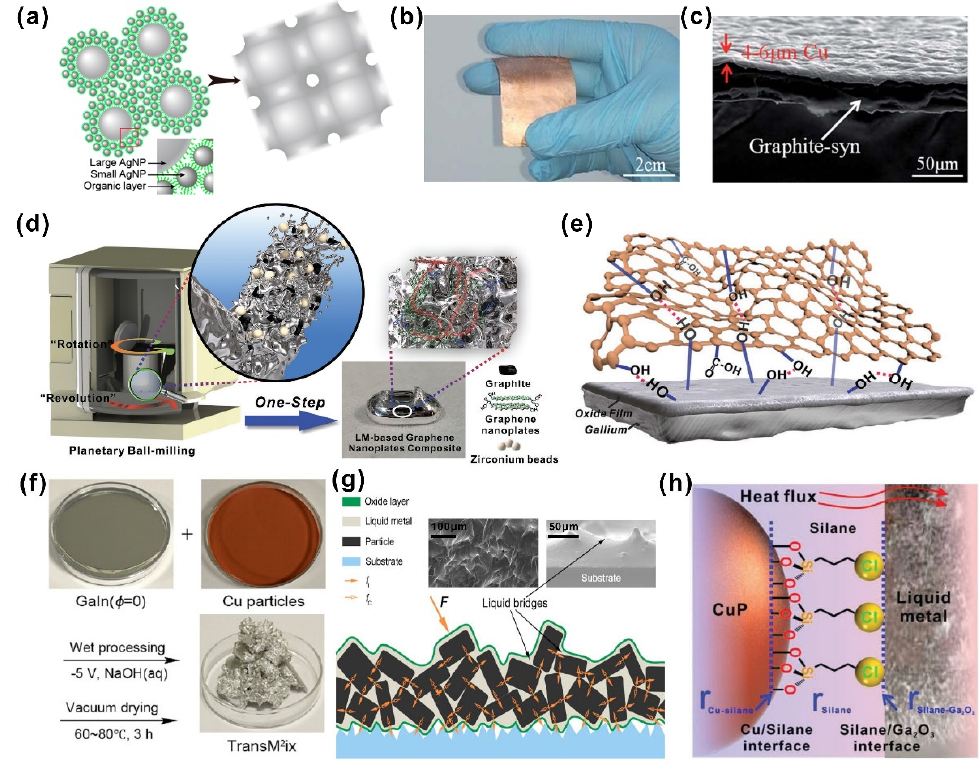
Figure 3. ( a ) The bimodal silver nanoparticle pastes via a sintering approach (Reprinted/adapted with permission from Ref. [65]. 2015, the American Chemical Society). ( b ) The picture of copper–graphite–copper (Cu–G–Cu) sandwich ‐ structured TIMs. ( c ) The cross ‐ sectional SEM image of the Cu–G–Cu sandwich (Figure 3b,c reprinted/adapted with permission from Ref. [59]. 2016, Royal Society of Chemistry). ( d ) Schematic illustration of the facile one ‐ step ball milling procedure to construct 3D thermal conductive graphene network. ( e ) The hydrogen bonding interaction between graphene nanoplates and liquid metal oxide (Figure 3d,e reprinted/adapted with permission from Ref. [61]. 2021, Wiley). ( f ) The fabrication of obtained “TransM 2 ixes” liquid metal amalgams. ( g ) Schematic illustration of efficient thermal conduction paths constructed by the compact stacking of copper particles within liquid metal nanobridges (Figure 3f,g reprinted/adapted with permission from Ref. [72]. 2017, the American Chemical Society). ( h ) The strong electrostatic interactions between CPTES covering the surface of copper particles with the freshly generated gallium oxide layer inside liquid metals. (Reprinted/adapted with permission from Ref. [62]. 2021, Wiley).